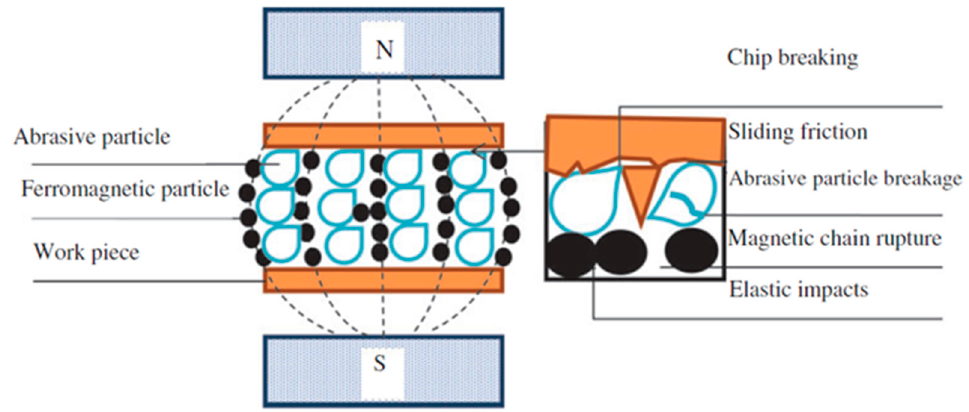
Figure 1. Material removal mechanism in a magnetic abrasive finishing (MAF) process [3].